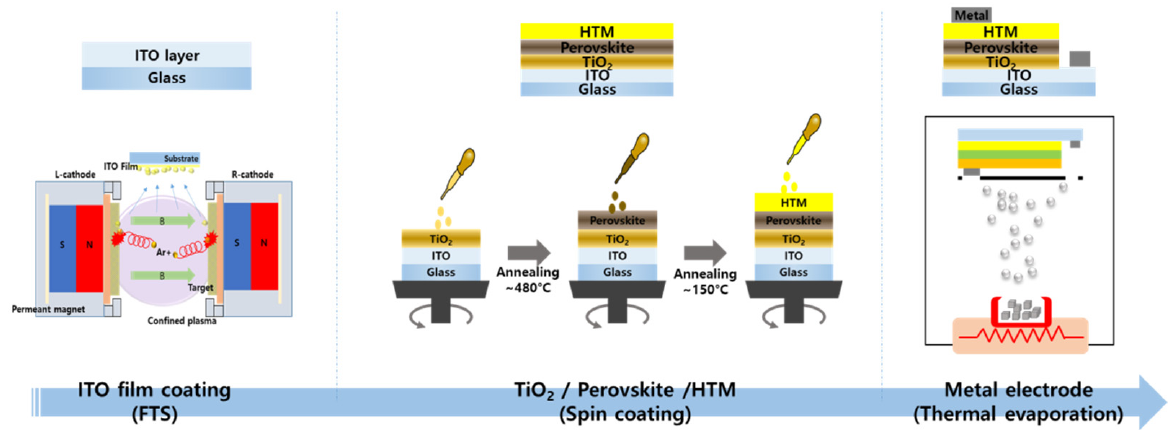
Figure 1. Schematics of perovskite solar cells (PSCs) with ITO-film-fabrication procedure.